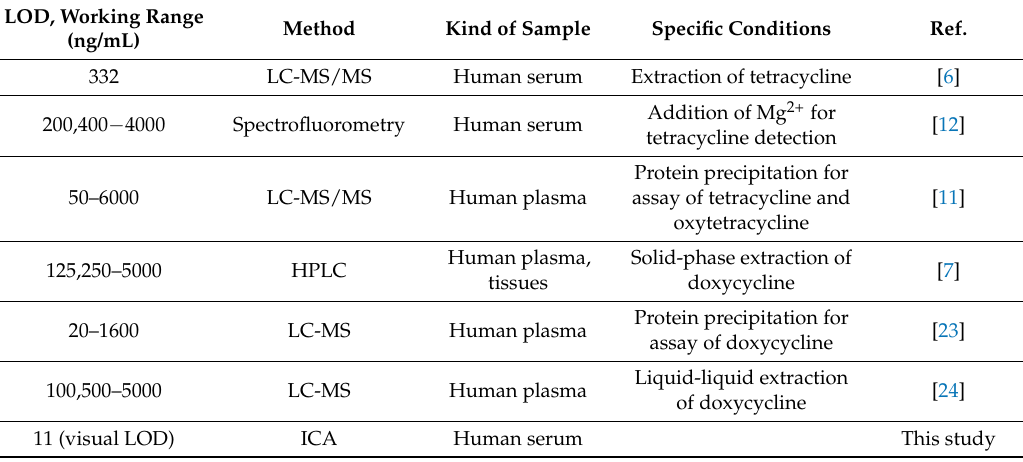
Table 4. Methods of detection tetracycline and structurally related compound doxycycline in human